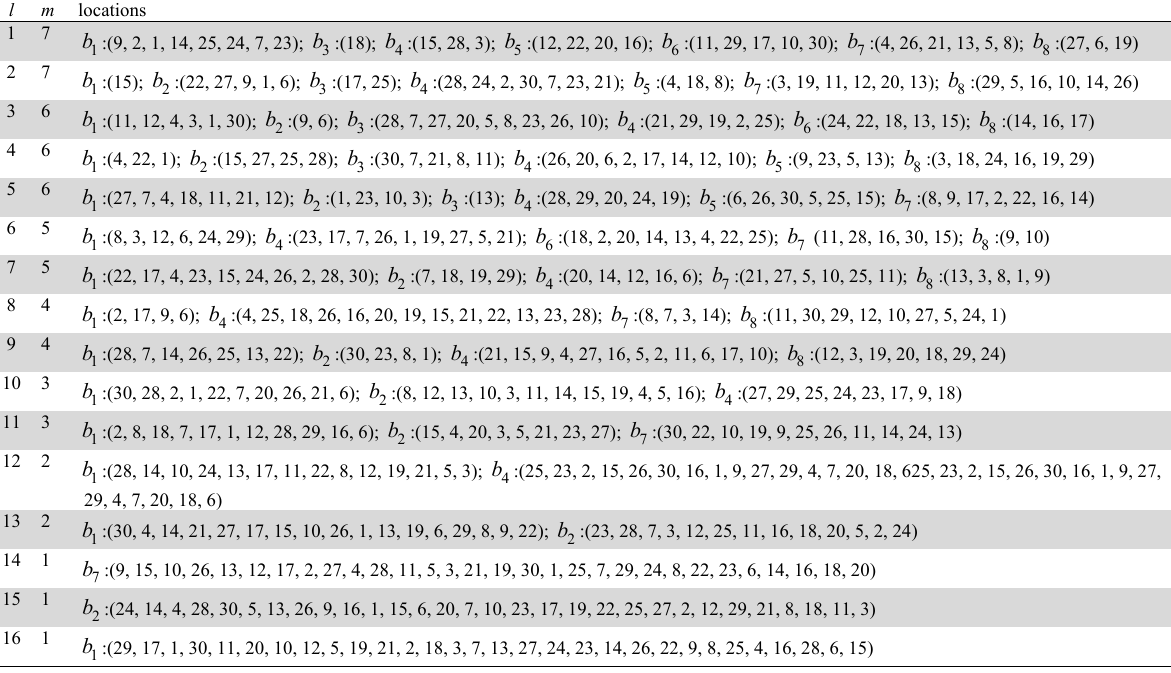
Sequences of tasks assigned by Alg_BC to m launched locations individual locations occurred in PF (last row)